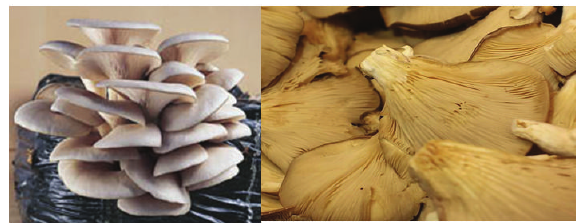
Figure 3: Pleurotus or “oyster mushroom” possesses medicinal properties and health-promoting